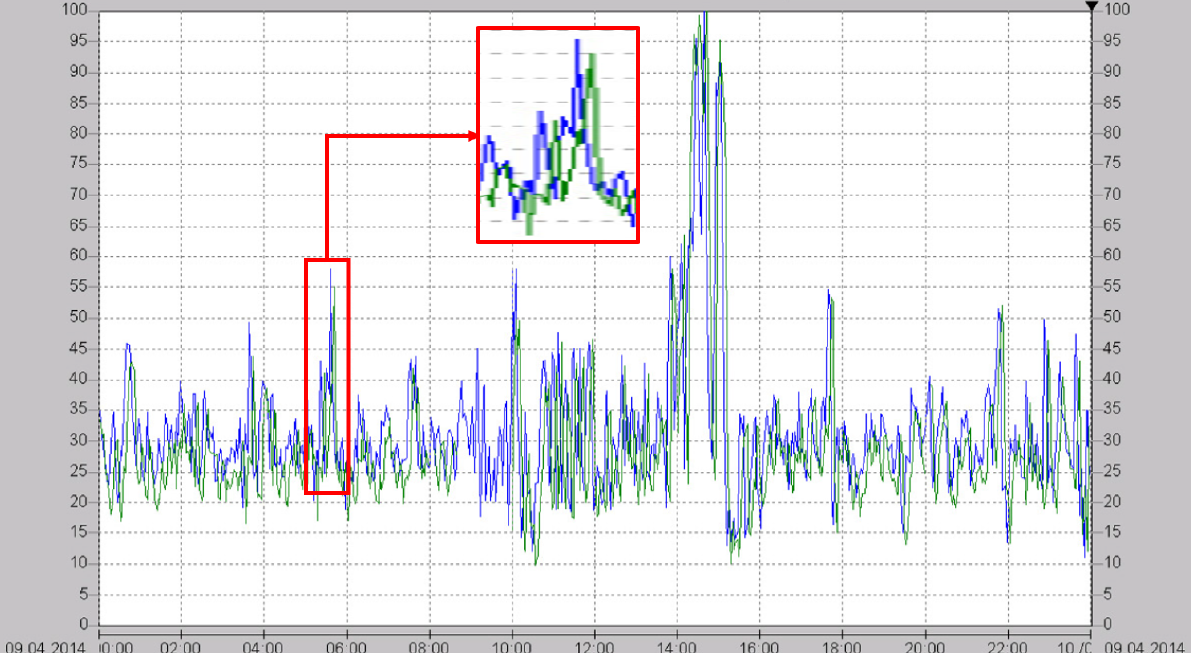
Figure 12. Twenty-four-hour comparison plot of the presented MIR NO sensor (blue) measuring the raw gas close to the combustion process and the final emission measurement of the clean gas at the chimney (green) [20]. Both concentrations are expressed as mg/m 3 . The inset shows the concentration readings between 5:00 and 6:00 in more